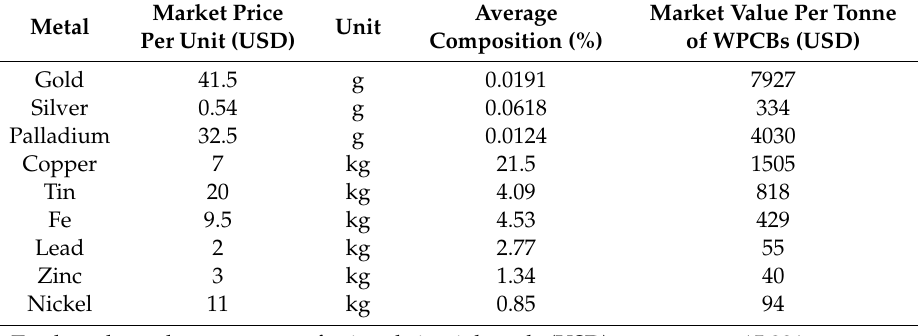
Table 2. Market value of printed circuit